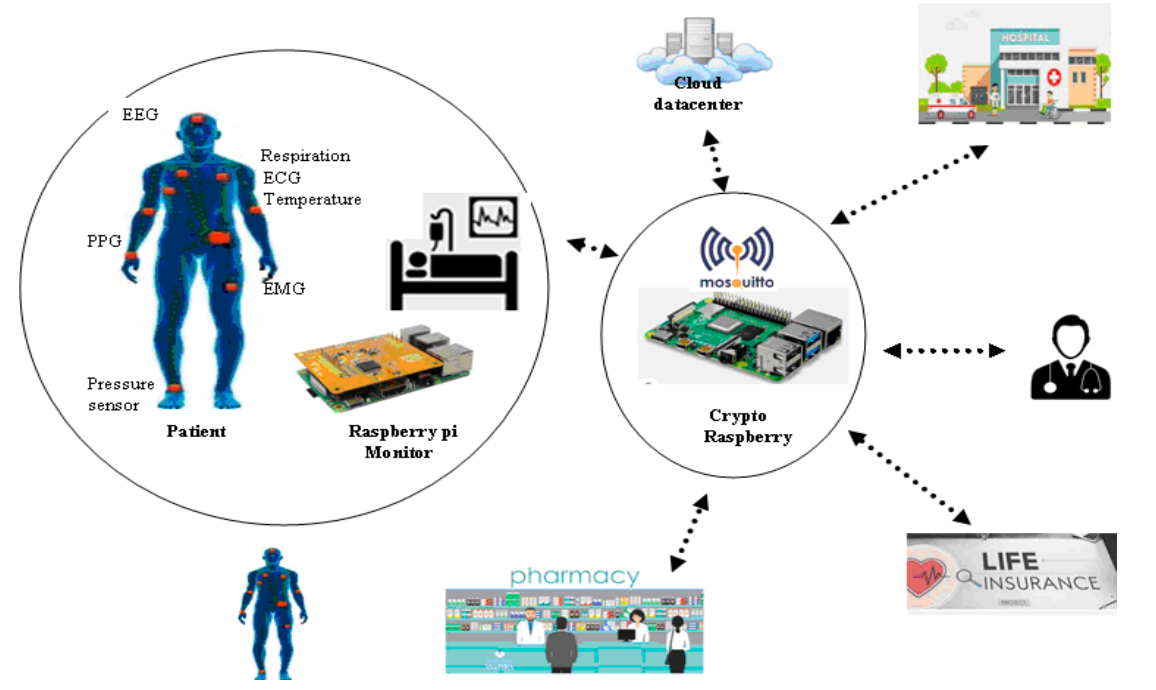
Figure 1. Embedded platform for the collection, use and management of medical and pharmaceutical data.